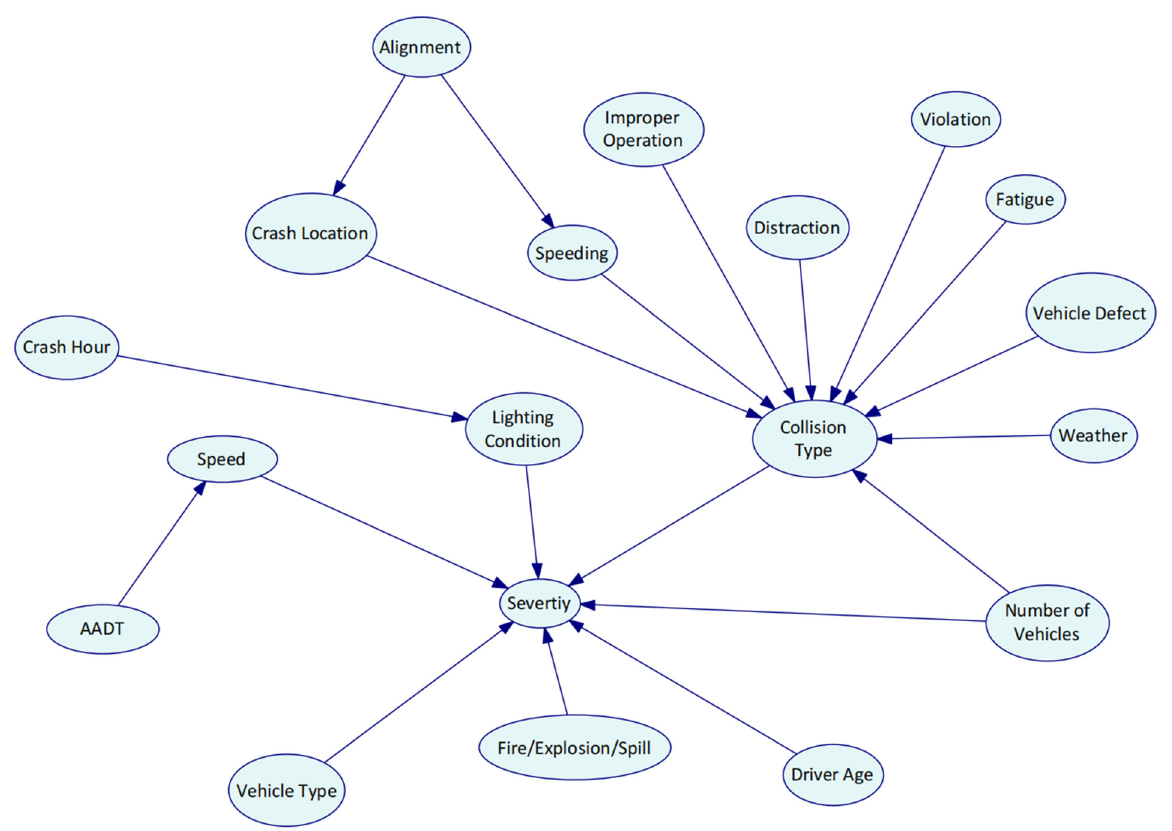
Figure 3. The Bayesian network structure development.